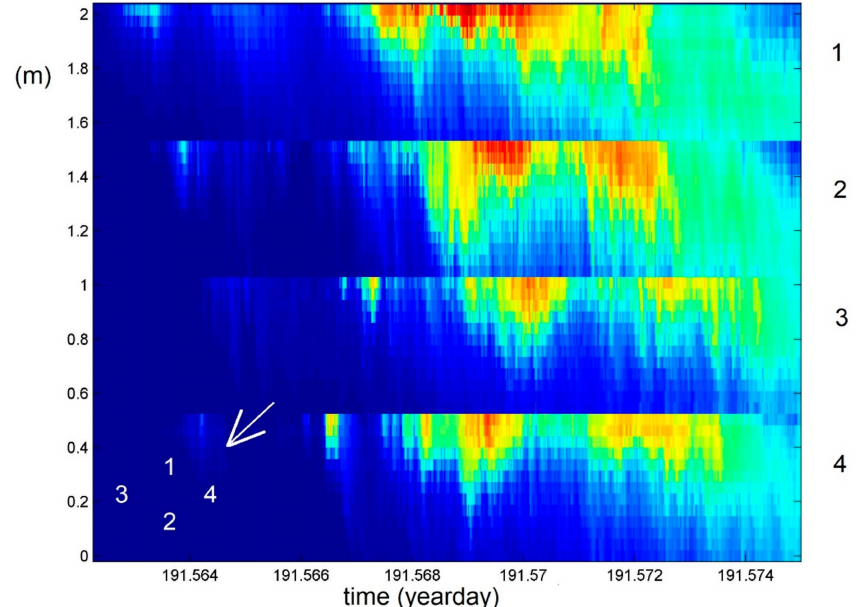
Figure 9. Seventeen minutes and 0.5 m depth range of slow propagation of internal wave turbulence past four mooring poles 4 m apart near Texel North Sea beach. The rippled waves came in from the NW, as indicated by the arrow. The depth range of the four poles are indicated cumulatively. The temperature range is [19.4, 19.9] ◦ C between dark-blue and red,